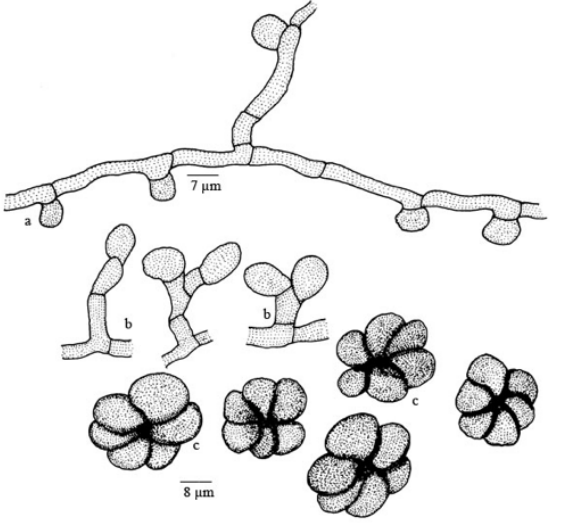
Figure 185. Sarcinella allophyli a - Appressoriate mycelium; b - Conidiophores; c - Sarciniform